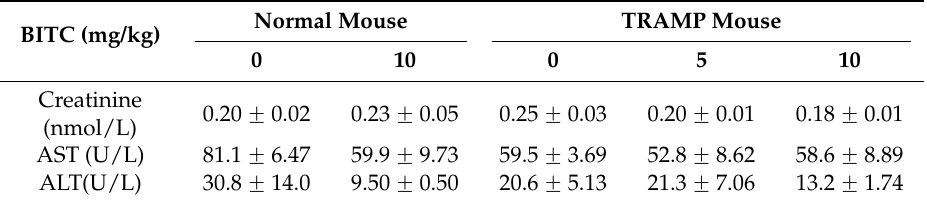
Table 2. Effect of BITC on the levels of creatinine and activities of AST and ALT in the sera of mice. Normal BITC (mg/kg)